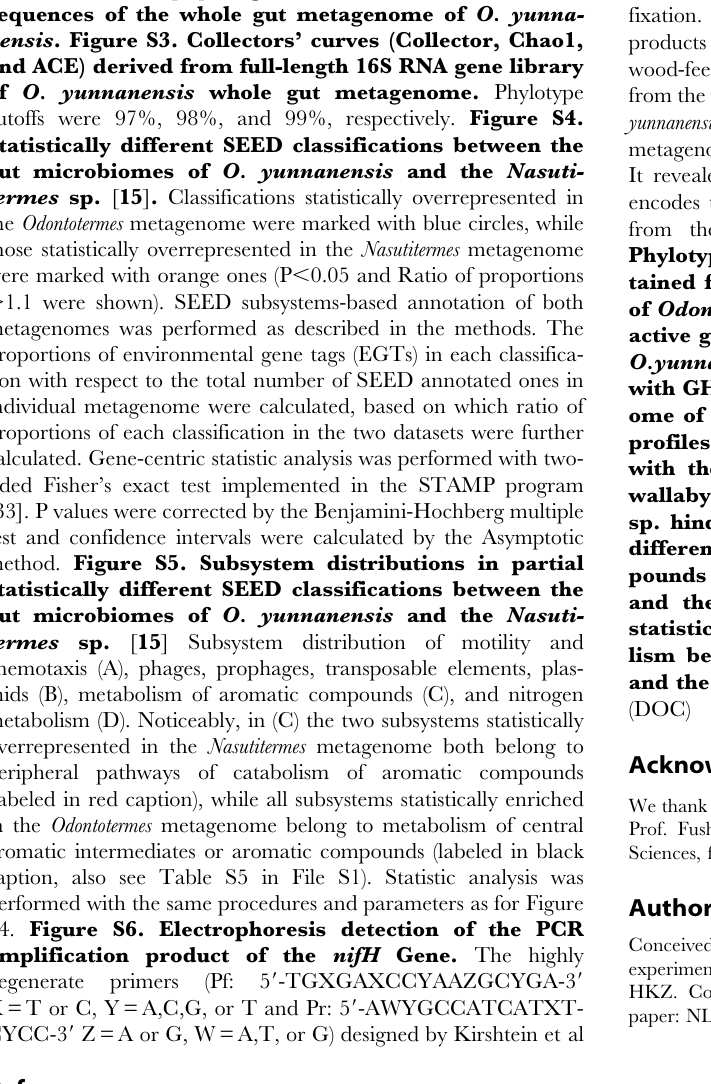
S4. Figure S6. Electrophoresis detection of the